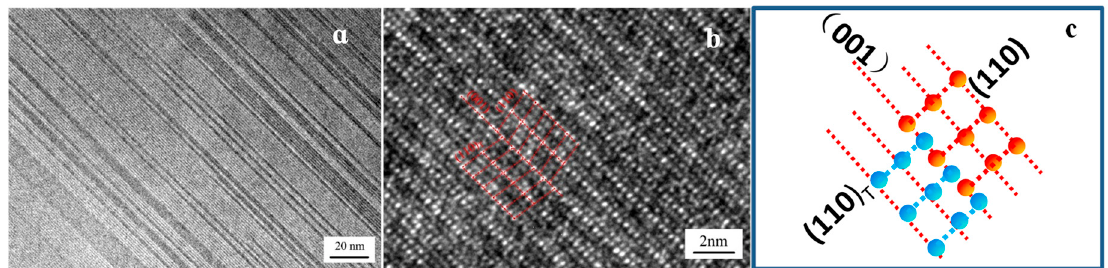
Figure 4. High-density twin morphology ( a ), high-resolution transmission electron microscopy (HRTEM) image of (001) twinning of Al 3 Fe phase ( b,c ).